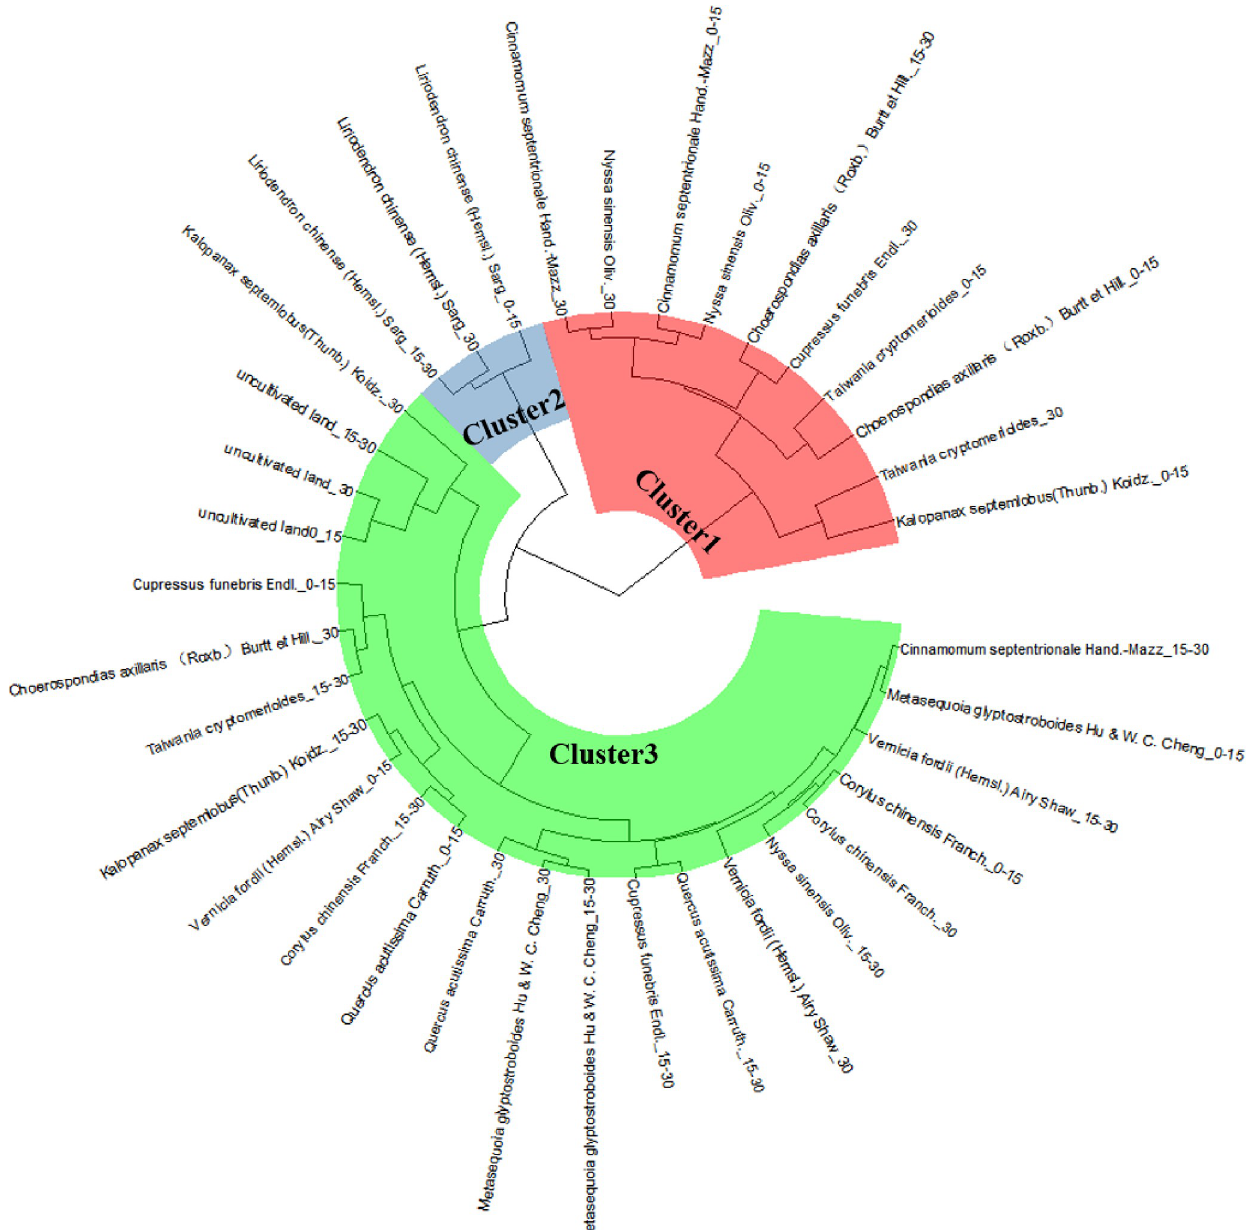
Fig 5. Cluster analysis of chemical properties of different vegetation